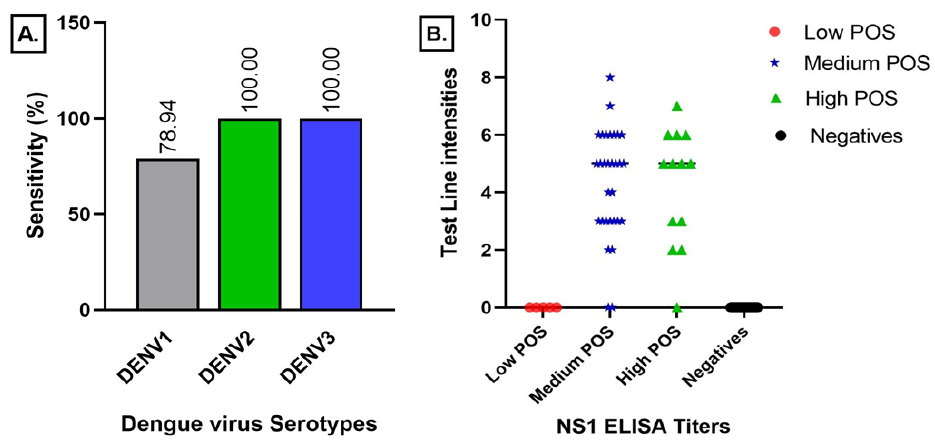
Figure 3. Correlation between the serotype versus visual scores ( A ) and ELISA NS1 ratios ( B ).